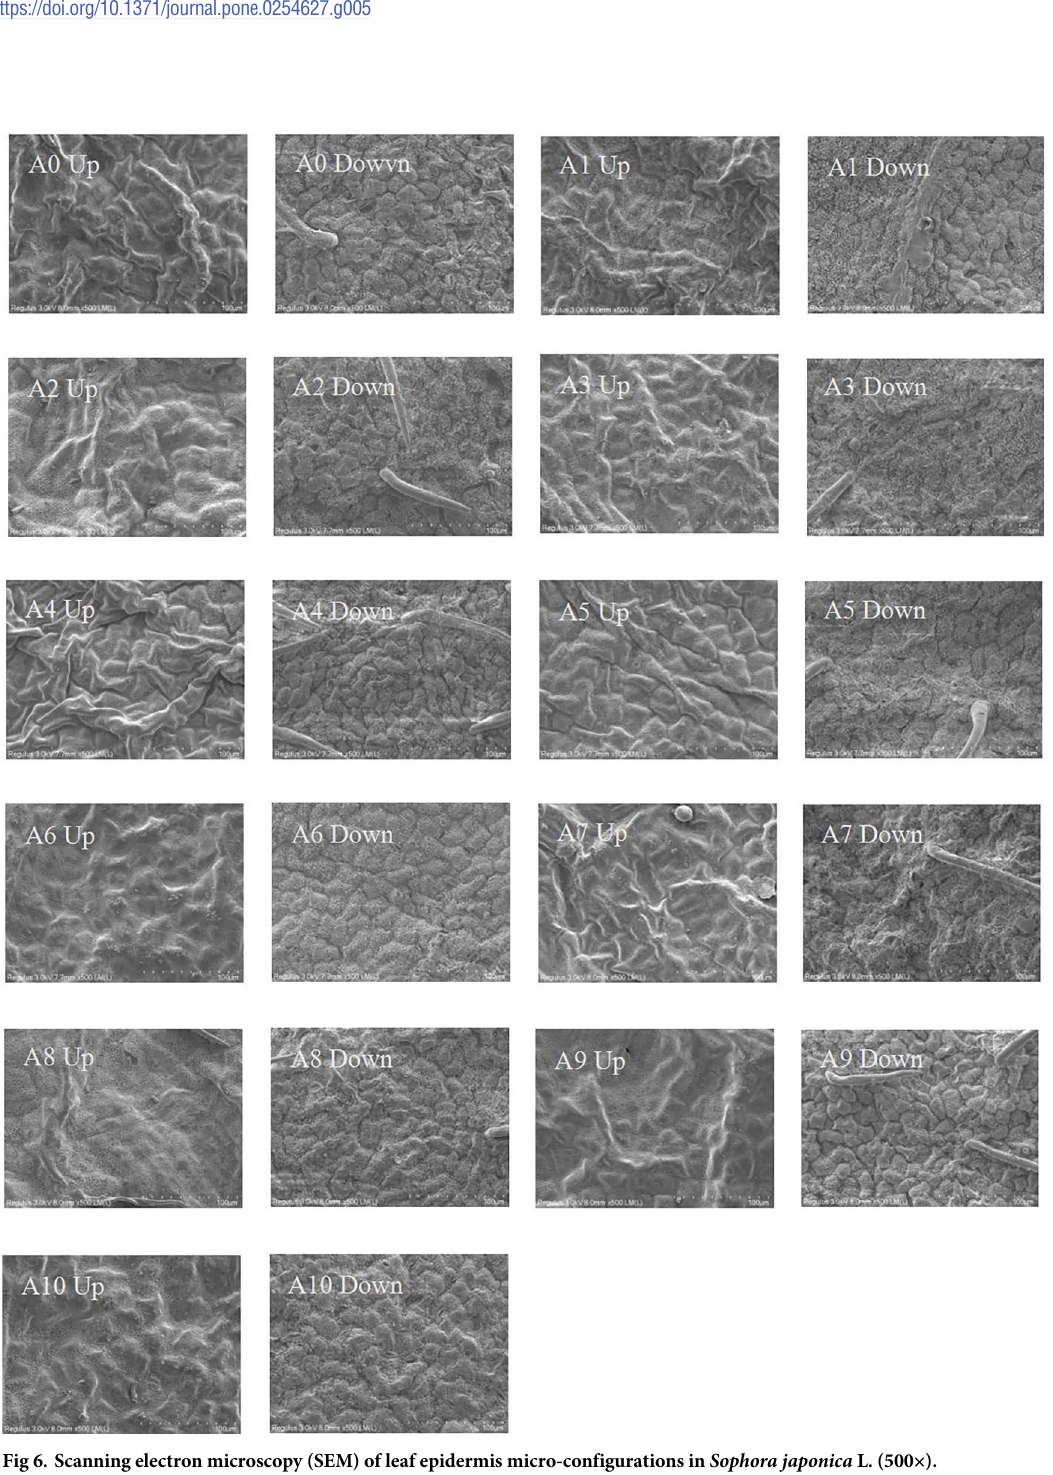
Fig 5. Unweighted pair group method with arithmetic mean (UPGMA) cluster analysis of the phenotypic traits of different clones of Sophora japonica L.